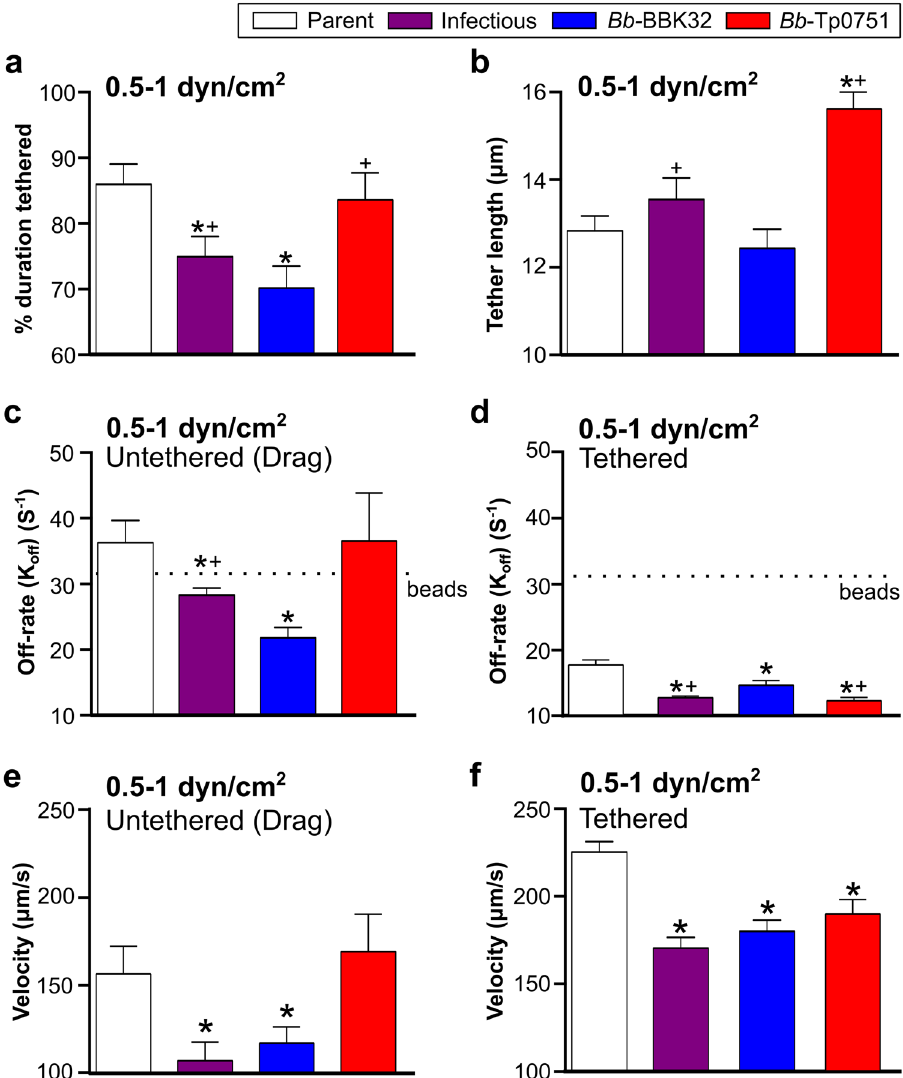
Figure 3. Effect of Tp0751 on tethered and untethered interaction stability and velocity under shear stress. B . burgdorferi interacts with endothelia under PCV shear stress conditions by two mechanisms: untethered (dragging) interactions, and tethered interactions. Tethered interactions are stabilized by bungee cord-like tethers which anchor bacteria to endothelia, reduce force imposed on load-bearing adhesion complexes and increase adhesion bond stability (lifetime) 29 . ( a , b ) Proportion of total bacterial-endothelial interaction times during which bacterial length extended beyond the normal length, indicative of tether formation stabilizing the interaction (( a ) % duration), and the average tether length ( b ) for all interactions at 0.5–1 dyn/cm 2 . ( c , d ) Interaction complex dissociation rates for untethered ( c ) and tethered ( d ) interactions. Dotted lines indicate dissociation rates for non-specific interactions (non-adherent beads). ( e , f ) Velocities of untethered ( e ) and tethered ( f ) interactions. Summary values: mean ± 95% CI ( a , b , e , f ), mean ± SEM ( c , d ). Interaction properties were calculated from interactions obtained at both 0.5 and 1 dyn/cm 2 . N = 4 and N = 8 independent flow chamber experiments for each strain at 0.5 and 1 dyn/cm 2 , respectively. Strains: Negative control strain: BBK32- deficient non-infectious adhesion-attenuated B31-A-derived strain (Parent; GCB706: Supplementary Table S1). Positive control strains: Parent expressing B . burgdorferi vascular adhesin BBK32 ( Bb -BBK32); BBK32- expressing B31-derived infectious strain (Infectious; GCB726: Supplementary Table S1). Bb -Tp0751: Parent expressing Tp0751. Numbers of interactions analyzed/strain ( a , b ): ≥ 288; ( c , e ): parent (42), infectious (127), Bb - BBK32 (130) and Bb -Tp0751 (39); ( d , f ): parent (366), infectious (520), Bb -BBK32 (448), and Bb -Tp0751 (249). Statistics: one-way Kruskal-Wallis ANOVA with Dunn’s post-tests ( a , b , e , f ); one-way ANOVA with Holm-Sidak post-tests ( c , d ). * Indicates p < 0.05 vs parent. + Indicates p < 0.05 vs Bb